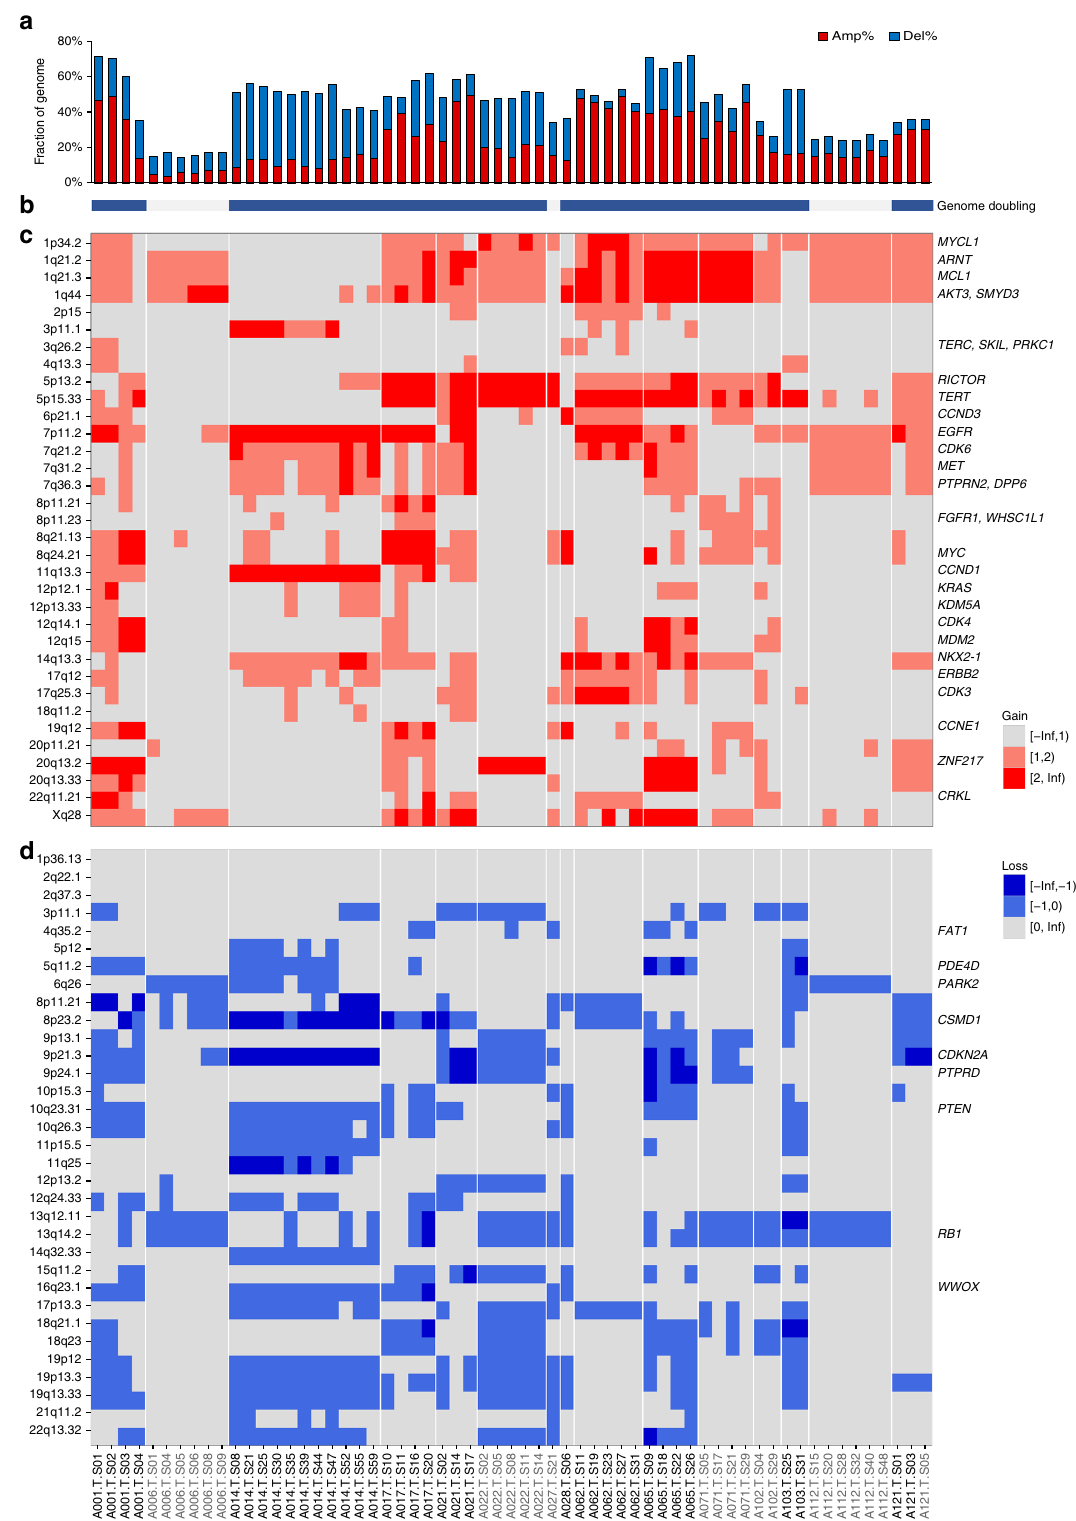
Fig. 2 Genomic instability and variegated copy number landscape of EGFR -mutant tumors. a Bar plot representing the fraction of genome altered by copy number alterations relative to ploidy of the sector, which is termed as the genomic instability index (GII). b Bar showing genome doubling status. Blue indicates signi fi cant evidence for genome doubling (Supplementary Data 3, Methods section) and gray indicates no genome doubling. c Heatmap depicting gains in known driver or recurrently ampli fi ed cytobands in LUAD (Methods section). Light red represents gain in one copy beyond the ploidy while dark red represents gain in ≥ 2 copies beyond the ploidy. d Heatmap depicting losses in known driver or recurrently ampli fi ed cytobands in LUAD (Methods section). Light blue represents loss of one copy relative to the ploidy while dark blue represents loss of ≥ 2 copies beyond the ploidy. Samples for all panels are as depicted in d . TP53 wild-type samples are depicted in